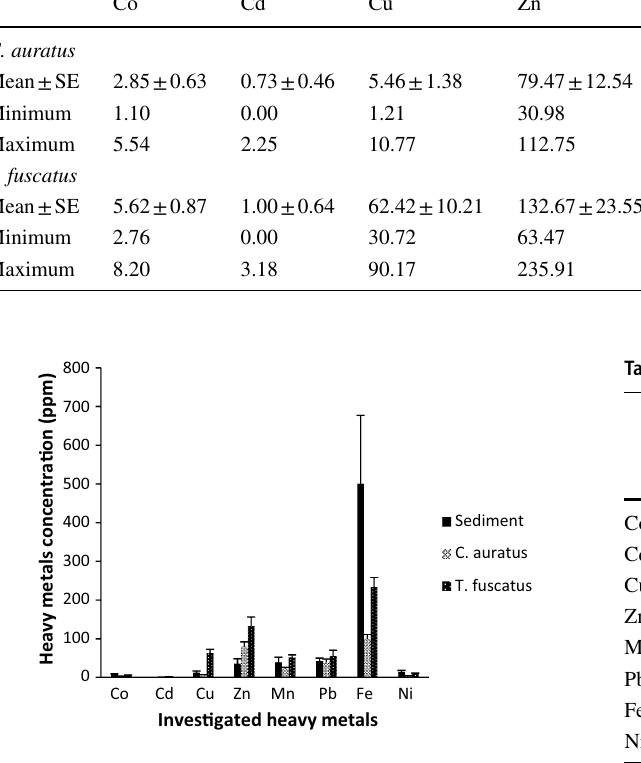
Fig. 6 Mean concentrations of heavy metals in the sediment and ben- thic fauna Table 6 Maximum permitted concentrations (mg/kg wet weight) for